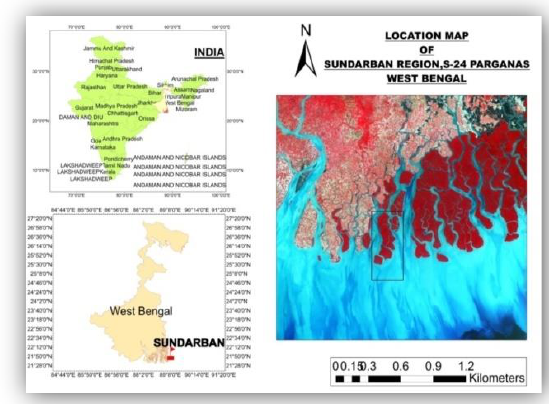
Figure 2: Study Area Sundarban South 24